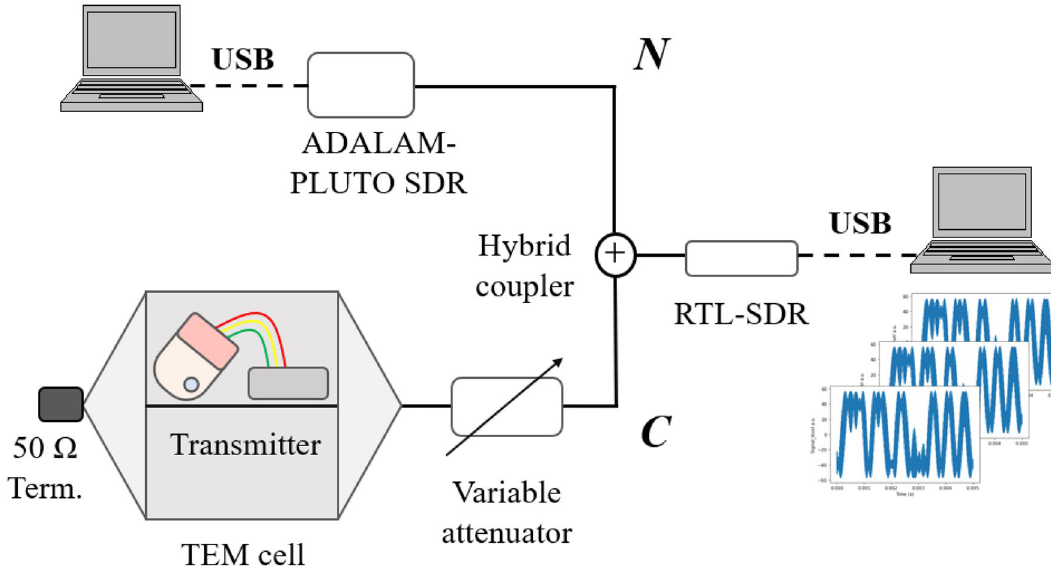
Figure 2. Measurement setup for WMT signals.